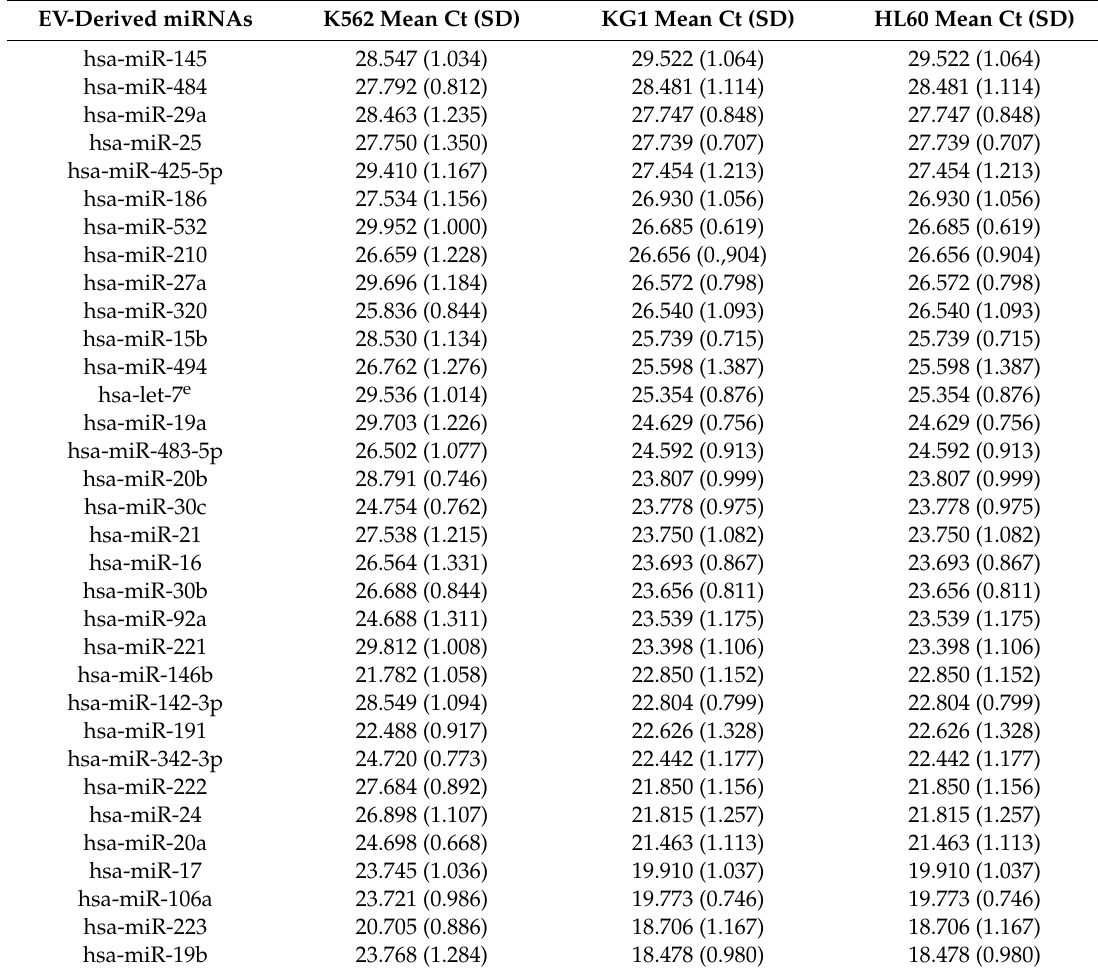
Table 2. Common miRNAs expressed in extracellular vesicles (EVs) derived from myeloid leukemia cell